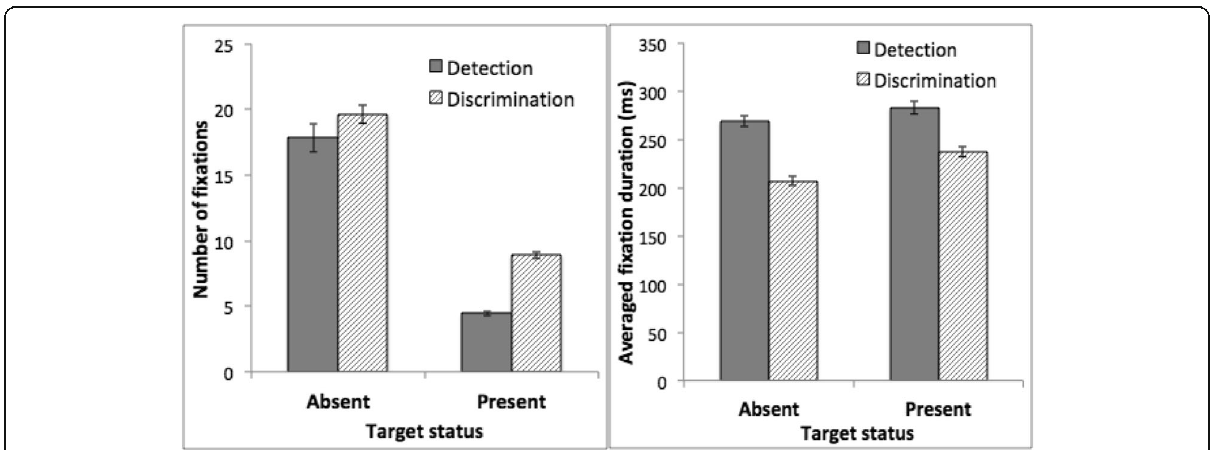
Fig. 4 Fixation data from the training phase of Experiment 2. Left : Average number of fixations per trial. Right : Mean fixation duration. Error bars show ±1 S.E. of the